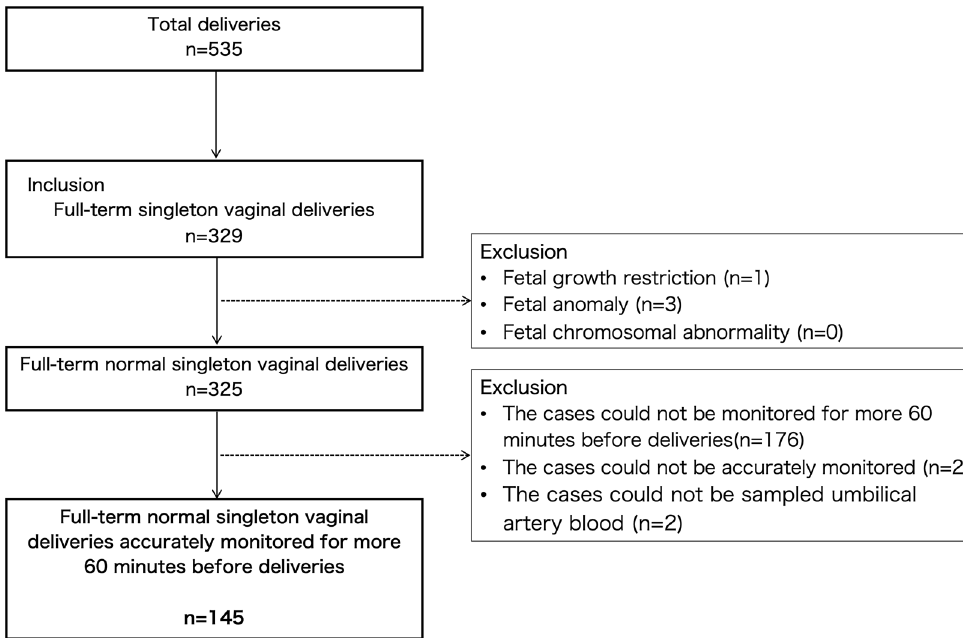
Figure 2. Flowchart for selecting study